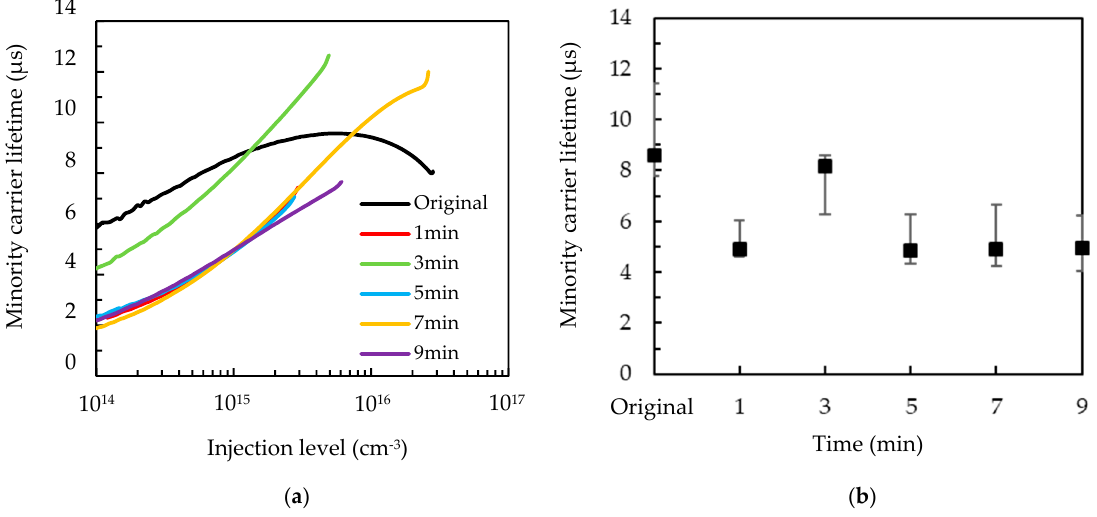
Figure 4. ( a ) Injection-level dependent minority carrier lifetime; and ( b ) average minority carrier lifetime at the injection level of 3 × 10 15 cm − 3 for the alkaline-etched silicon wafers with a di ff erent MACE time.